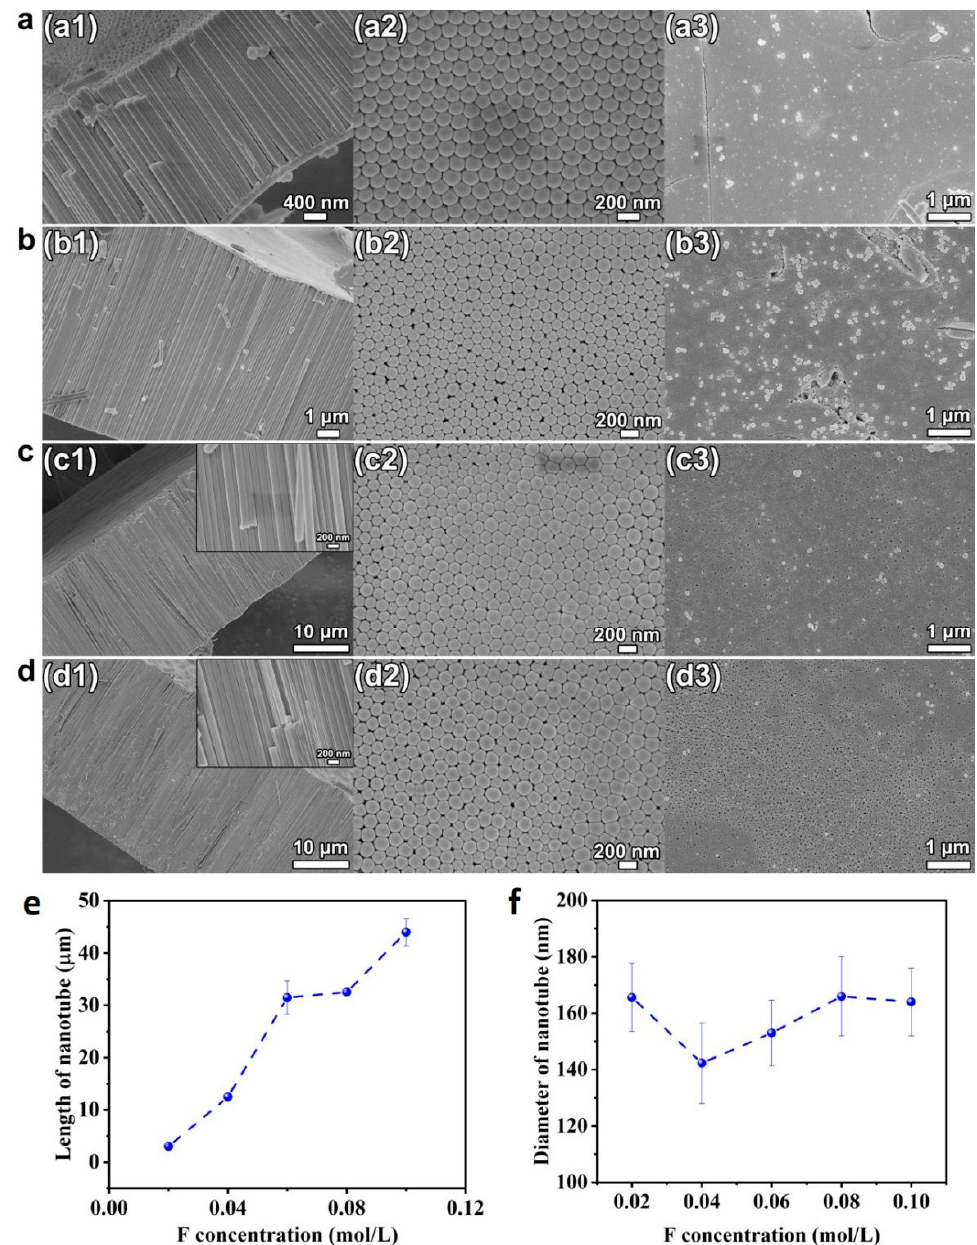
Figure 5. ( a – d ) SEM images of cross-sectional ( a1 – d1 ), bottom ( a2 – d2 ), and top views ( a3 – d3 ) of the HEO nanotube arrays formed under 60 V in the ethylene glycol solution containing 10 vol.% of water and different amounts of NH 4 F: ( a ) 0.02 mol/L, ( b ) 0.04 mol/L, ( c ) 0.06 mol/L and ( d ) 0.08 mol/L after the anodization for 4 h; ( e ) Changes in nanotube length and diameter ( f ) with fluoride